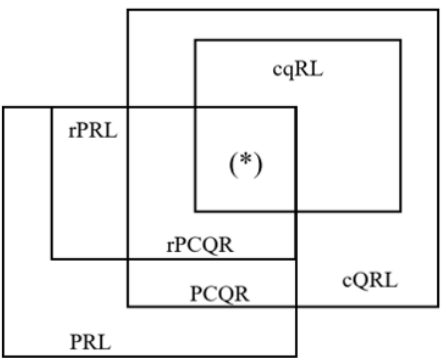
Figure 6. Relationship between some algebraic